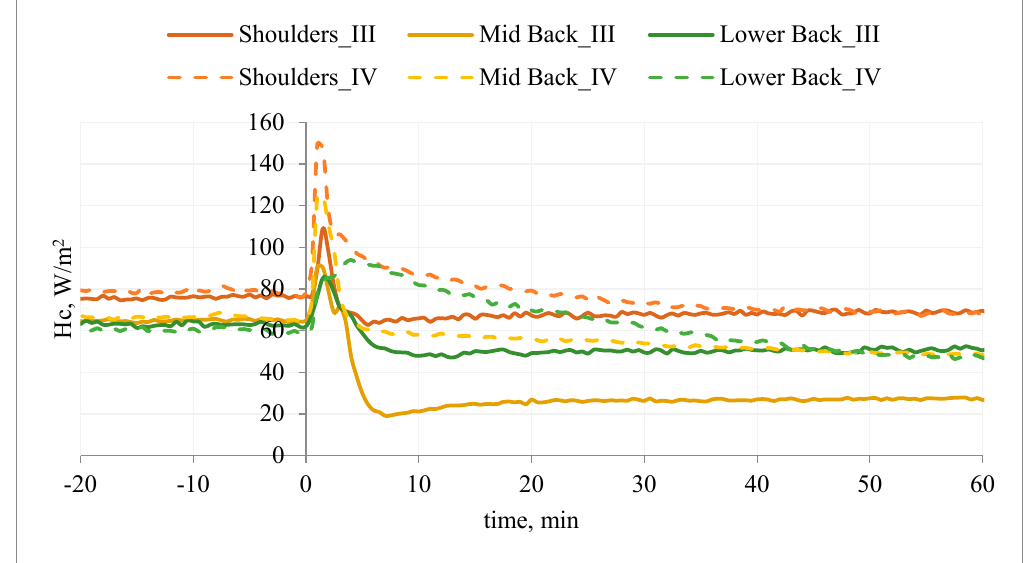
Figure 13. An example of the heat flux density, Hc, on selected manikin segments (back) during the test of T-shirt A without PCM together with outer garments (variant III) and T-shirt A with PCM together with outer garments (variant IV).